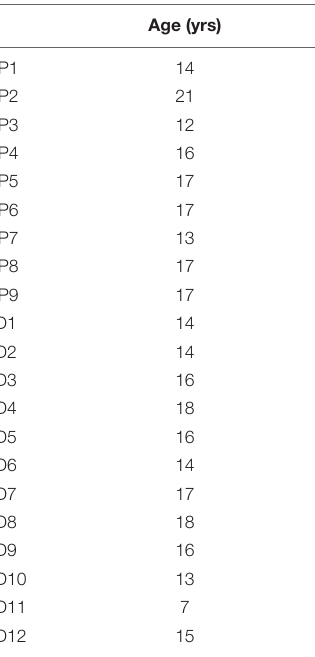
TABLE 1 | Participant